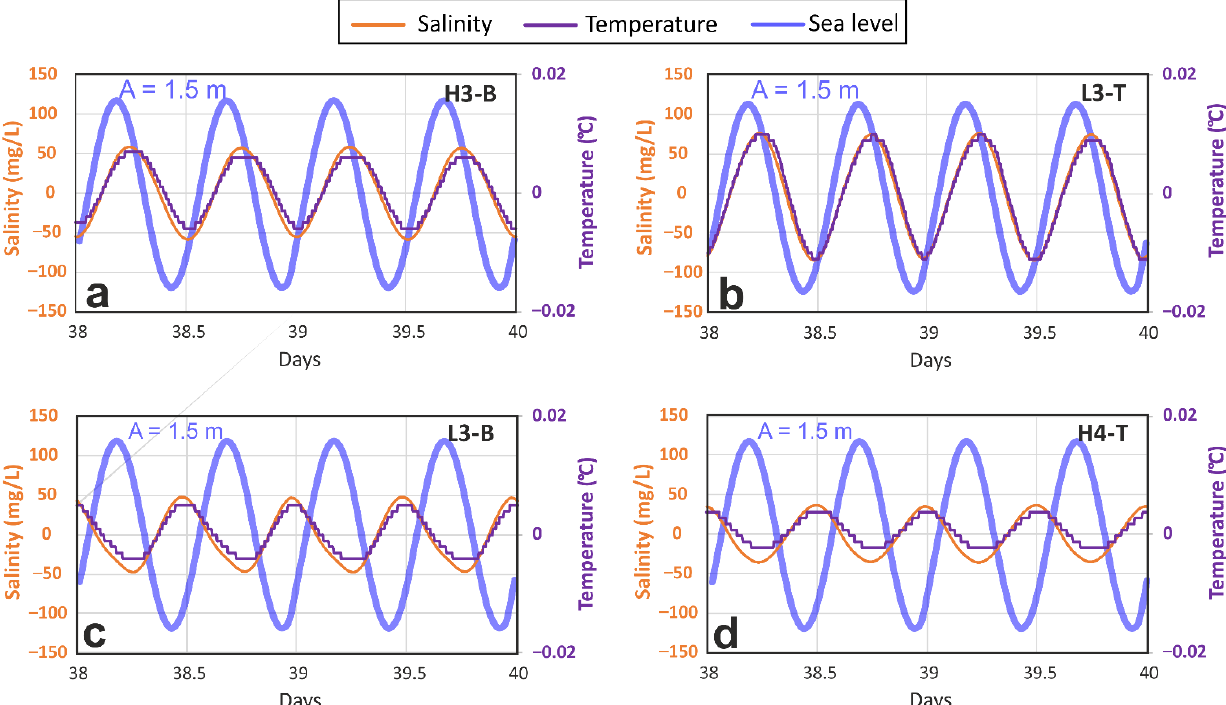
Figure 12. Simulation results of model B at four depths of the well W for a mesotidal condition (semi-amplitude of 1.5 m). ( a ): At the observation point H3-B ( − 122 m) ( b ): At the observation point L3-T ( − 123 m) ( c ): At the observation point L3-B ( − 138 m) ( d ) : At the observation point H4-T ( − 140 m).